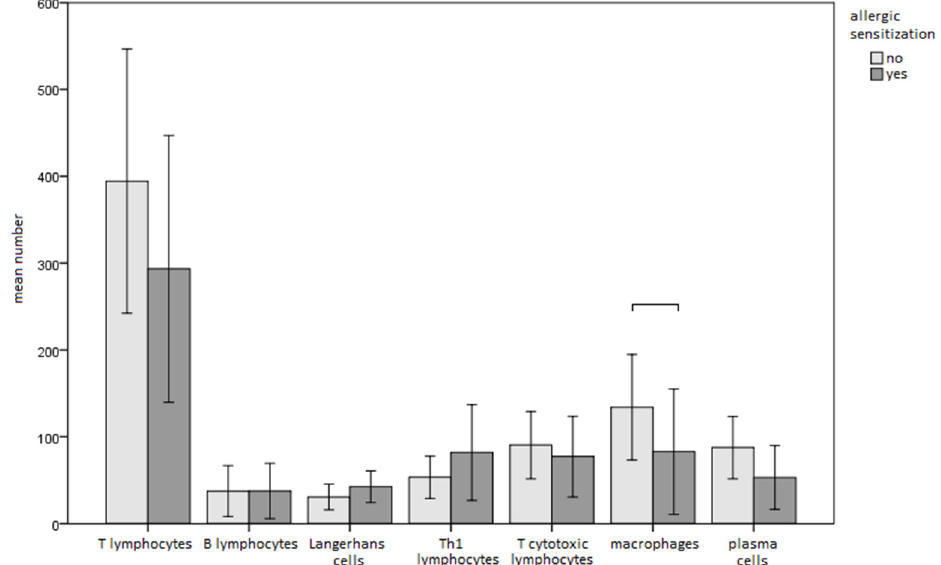
Figure 1. Comparison of immunohistochemical parameters between sensitised and non-sensitised subjects (bars represent means and whiskers 95% confidence intervals).